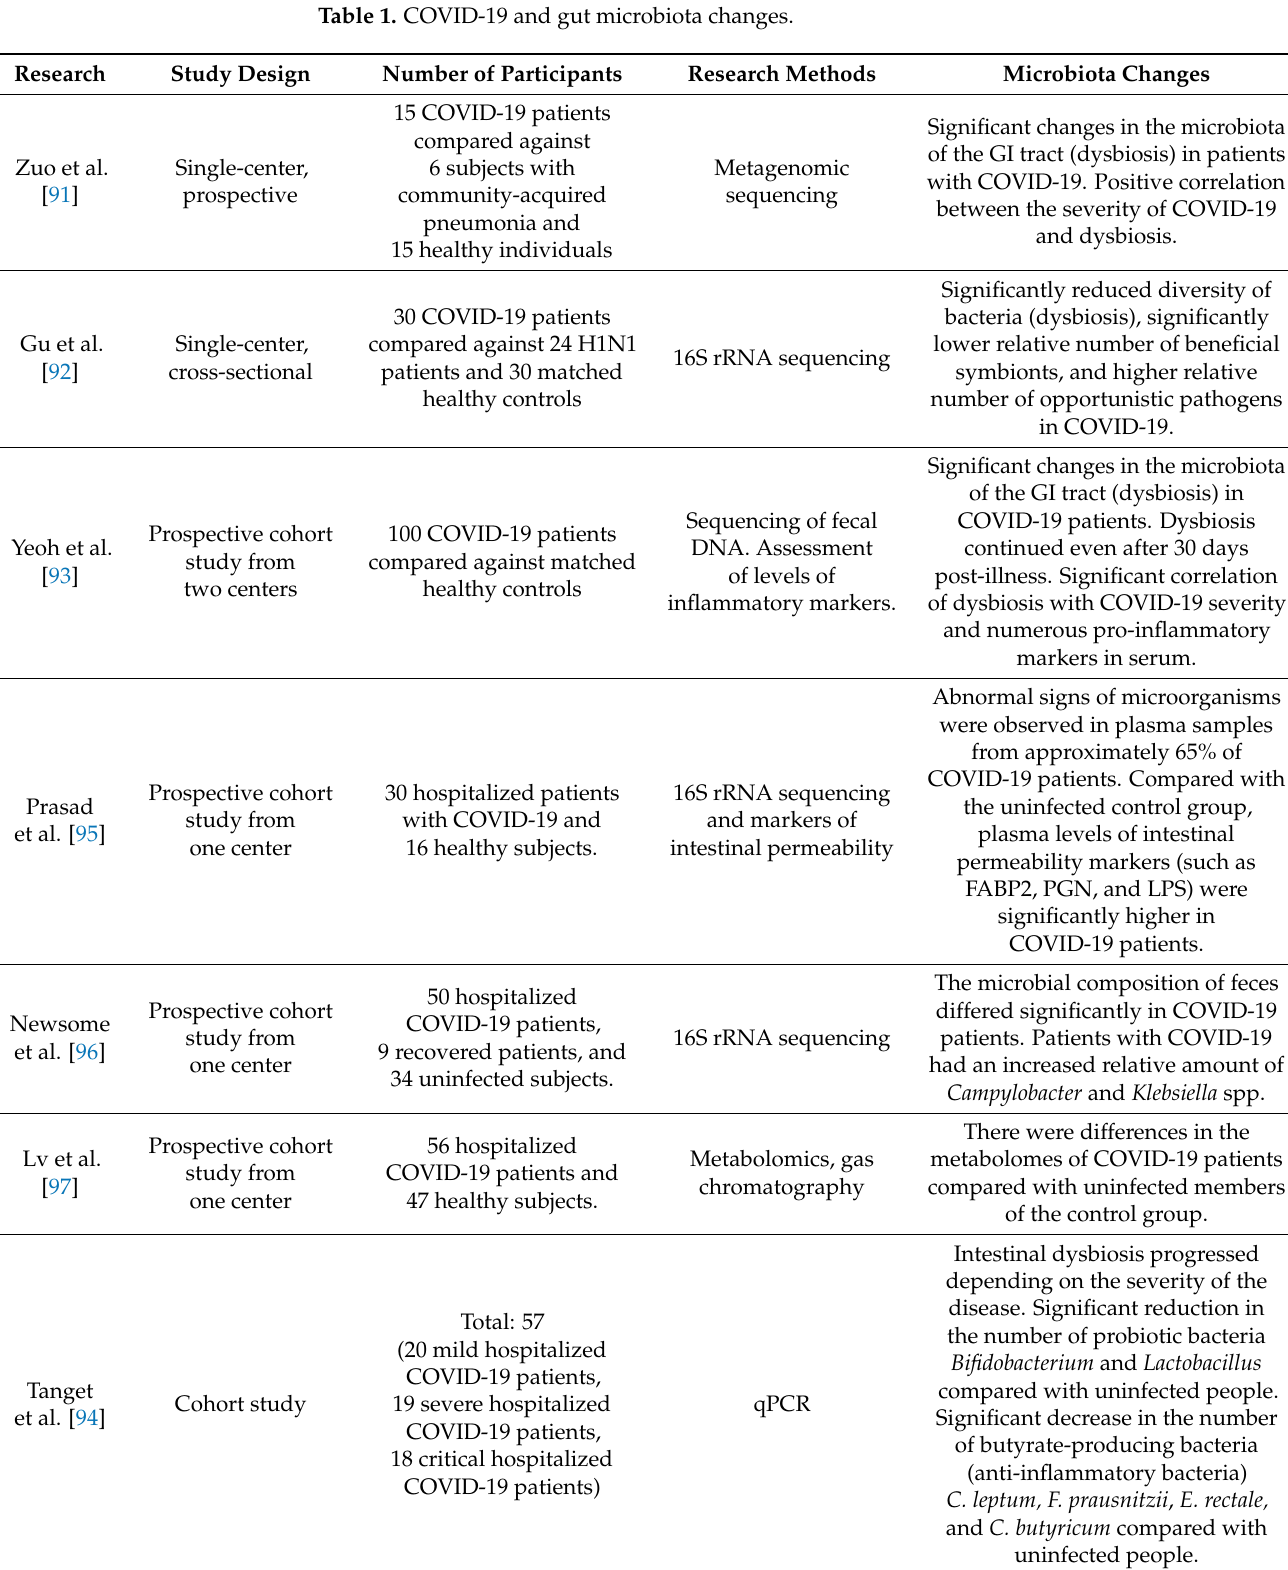
Table 1. COVID-19 and gut microbiota